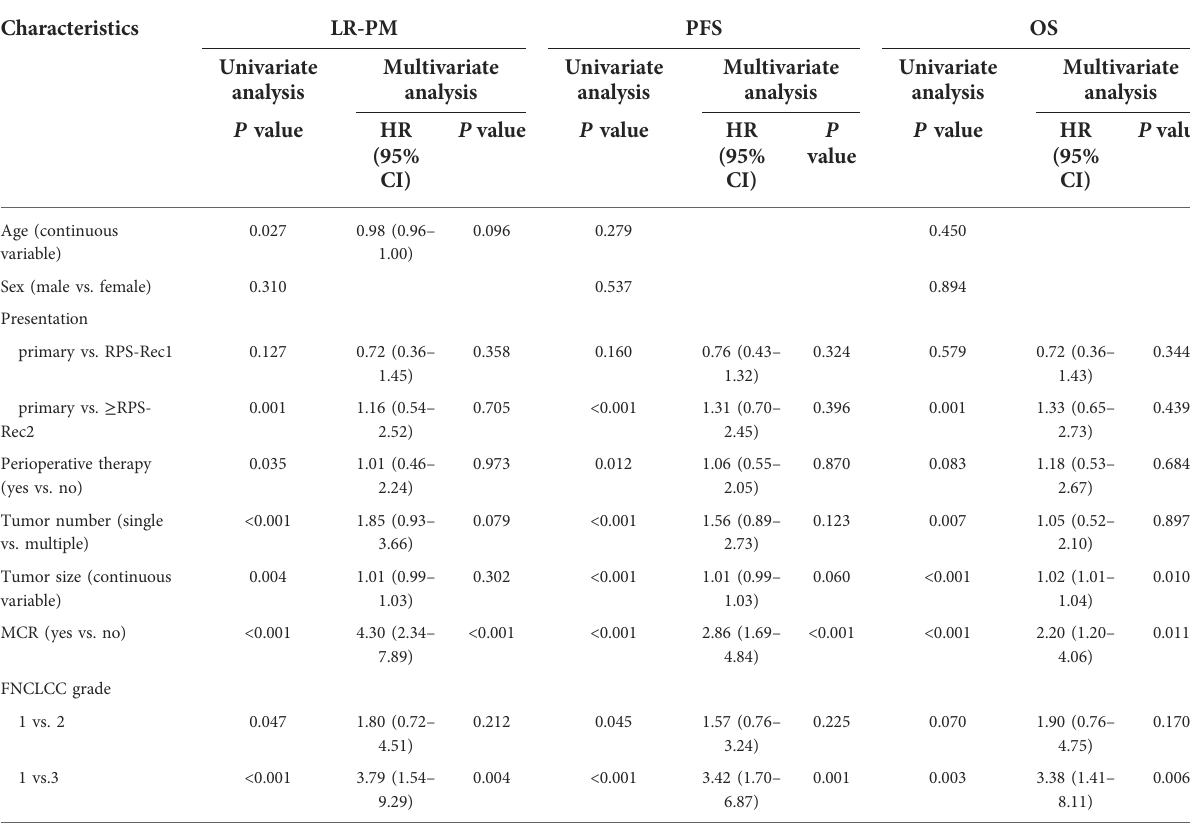
TABLE 2 Univariate and multivariate analyses of local recurrence and/or peritoneal metastasis (LR-PM), progression-free survival (PFS), and overall survival (OS).